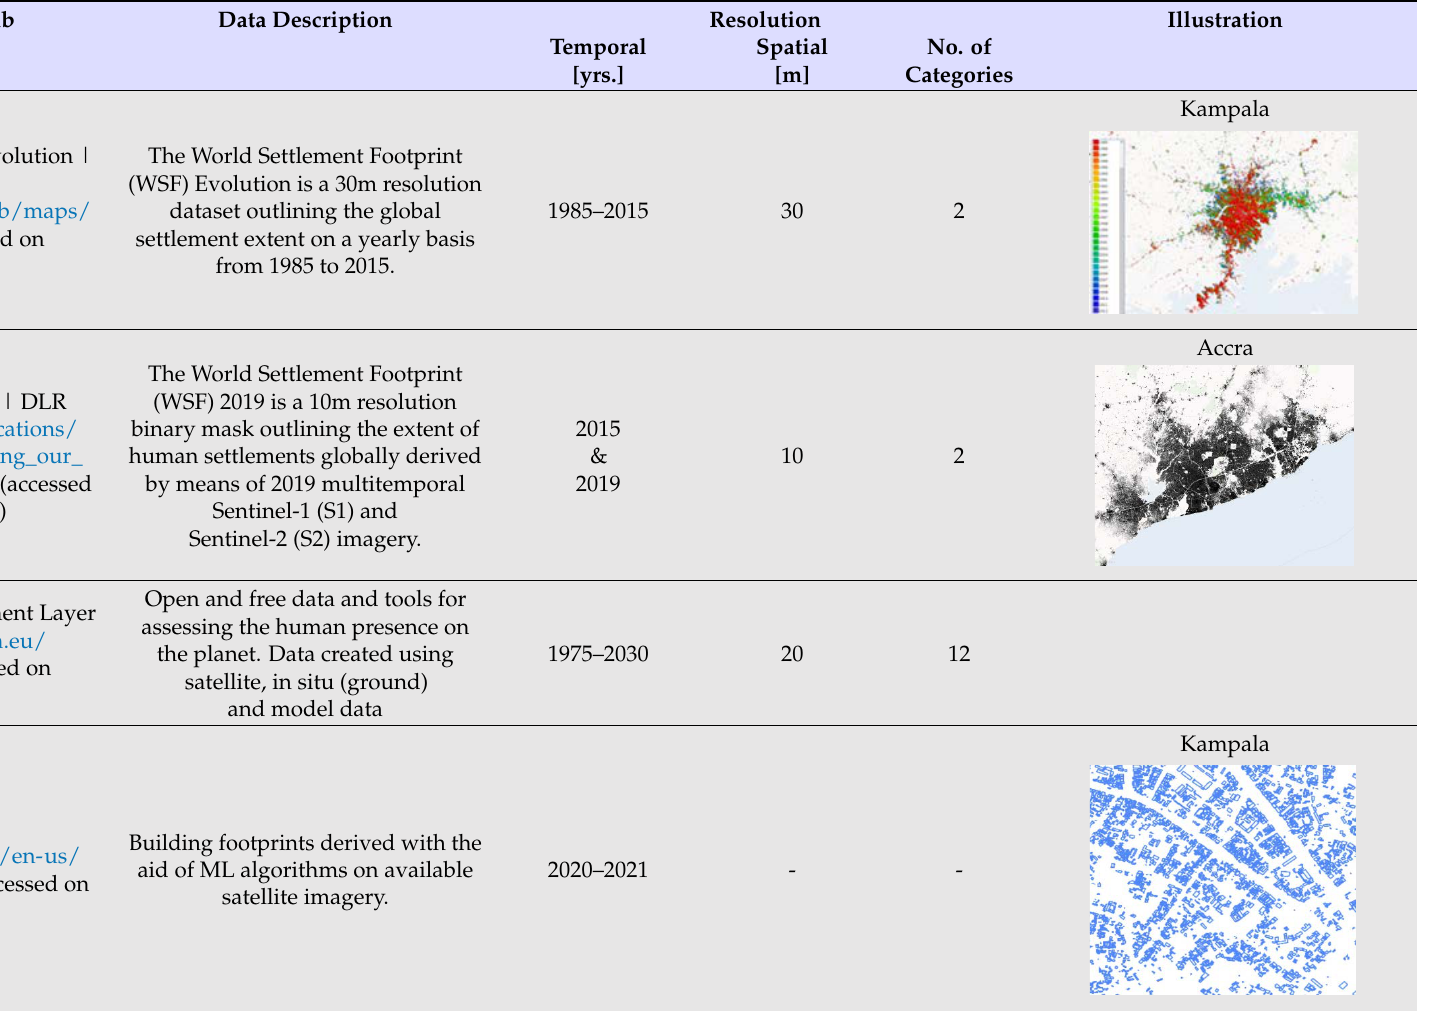
Table 2. Publicly available dataset revealing urban land use in different continents.